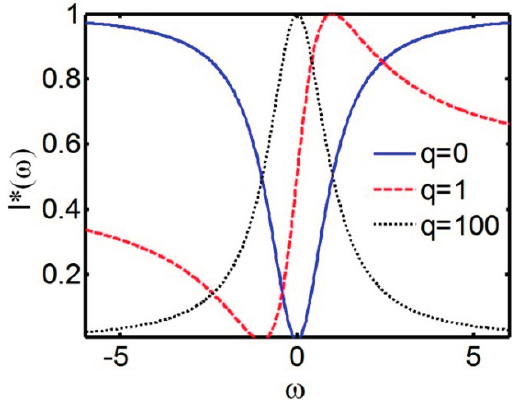
Figure 1. Normalized Fano resonance profiles for various values of the asymmetry parameter q versus normalized frequency, here I * is the normalized resonance amplitude and γ is the full width at half maximum of I